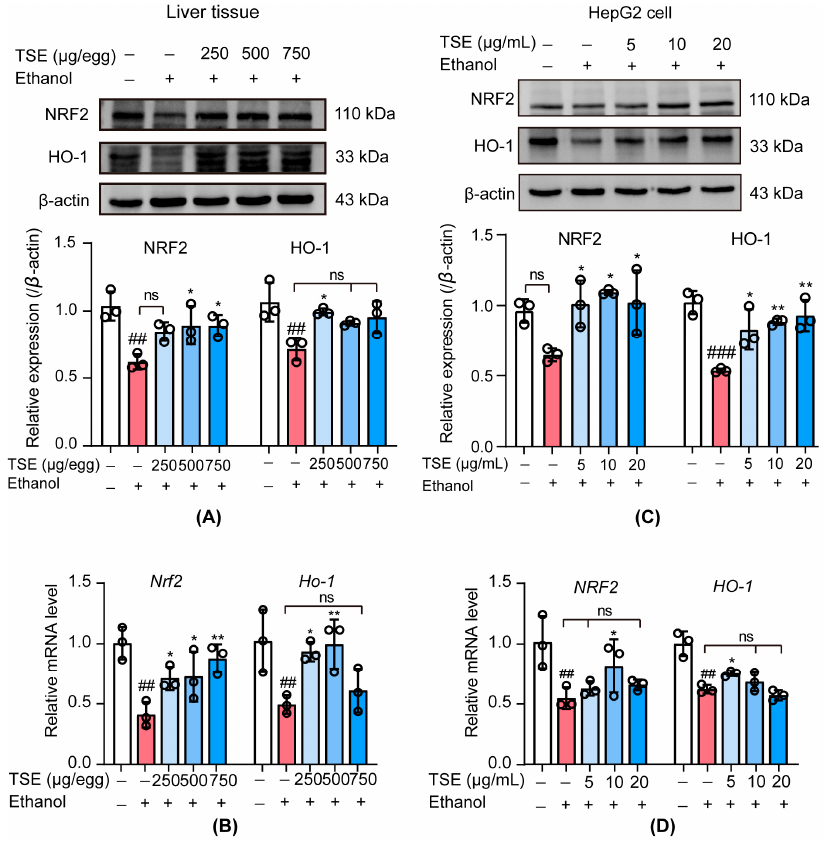
Figure 7. Effect of TSE on NRF2-mediated antioxidant signaling in ethanol-induced liver damage. ( A ) NRF2 and HO-1 protein expression levels in chicken embryo liver tissue, n = 3 biologically independent samples. ( B ) qRT-PCR analysis of the mRNA levels of Nrf2 and Ho-1 in chicken embryo liver tissue, n = 3 biologically independent samples. ( C ) NRF2 and HO-1 protein expression levels in HepG2 cells, n = 3 biologically independent experiments. ( D ) qRT-PCR analysis of the mRNA levels of NRF2 and HO-1 in HepG2 cells, n = 3 biologically independent experiments. Data represent the mean ± standard deviation and significant differences were analyzed by one-way ANOVA. ## p < 0.01, ### p < 0.001 vs. control group; * p < 0.05, ** p < 0.01 vs. ethanol group; ns, not significant vs. ethanol